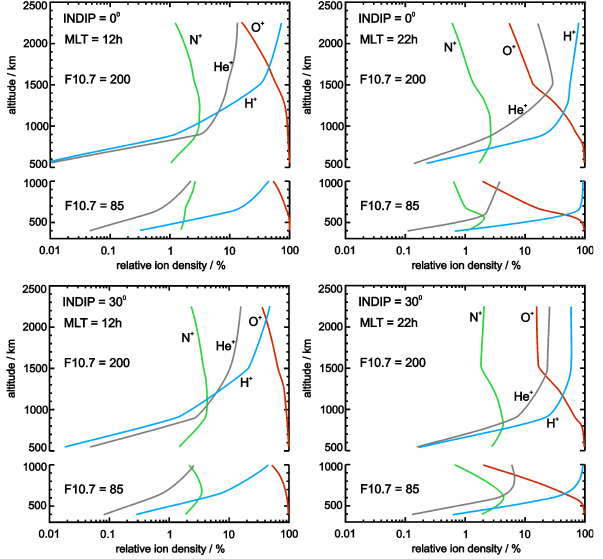
Fig. 7. Examples of equinoxial vertical profiles of the relative ion densities calculated from the TTS model for high (F10.7=200) and low solar activity (F10.7=85) and for two local times (12h and 22h) and two latitudes (0 ◦ and 30 ◦ ).